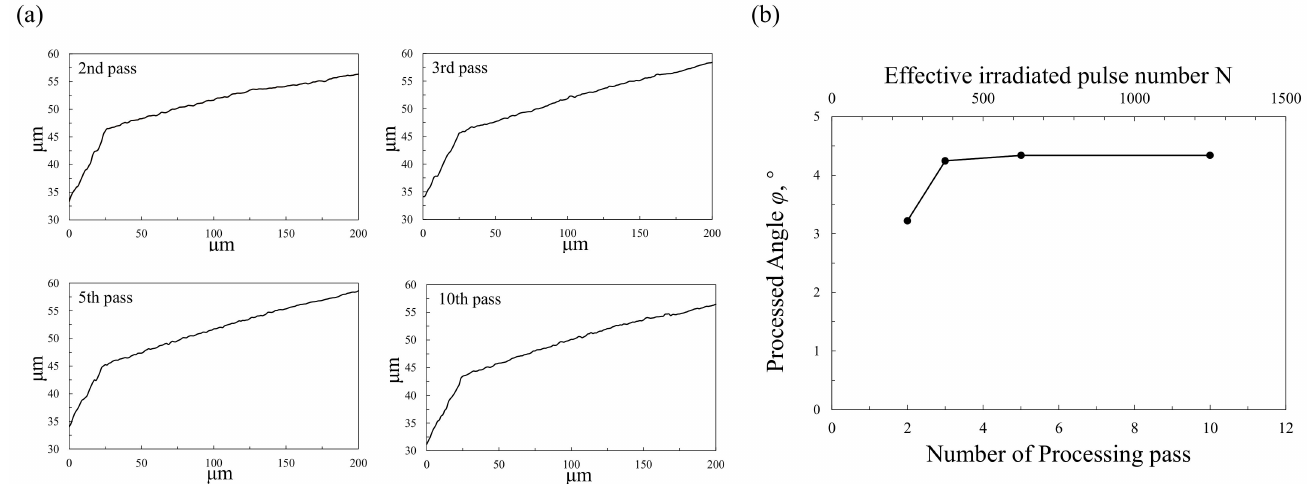
Figure 11. SEM image of the PLG-processed surface at the pulse pitch of 0.2 µ m with a magnification of ( a ) 150 and ( b ) 500.